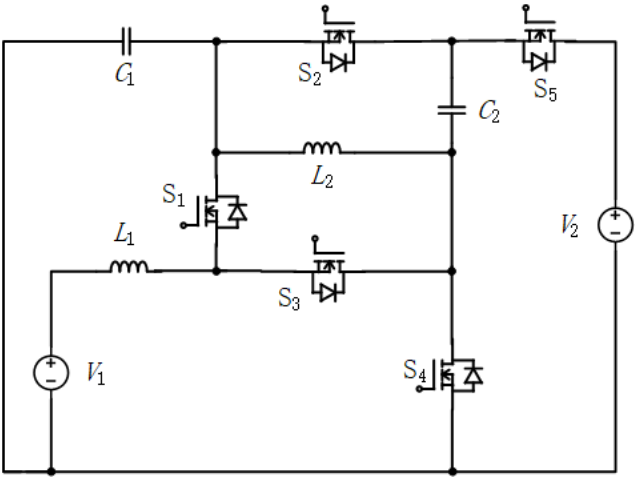
Figure 7. A non-isolated bidirectional DC-DC converter in [16].